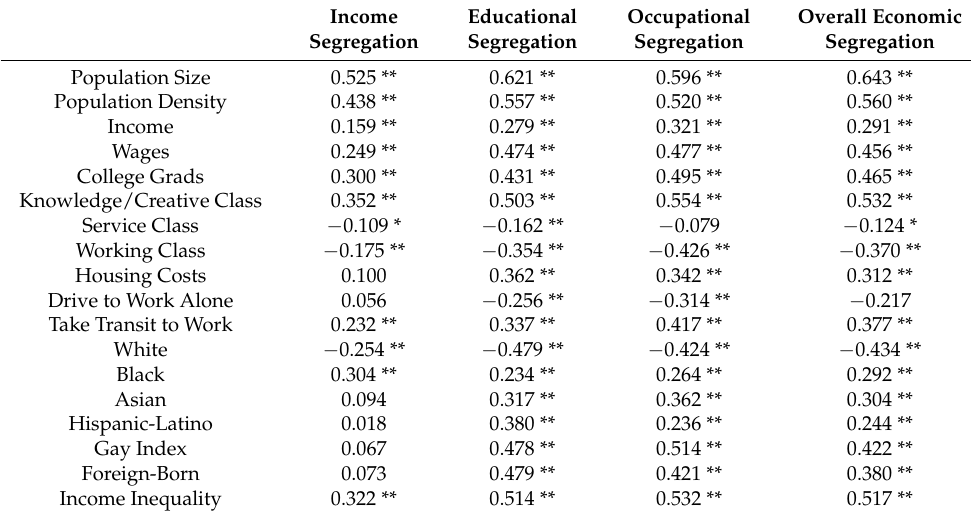
Table 3. Correlation Analysis